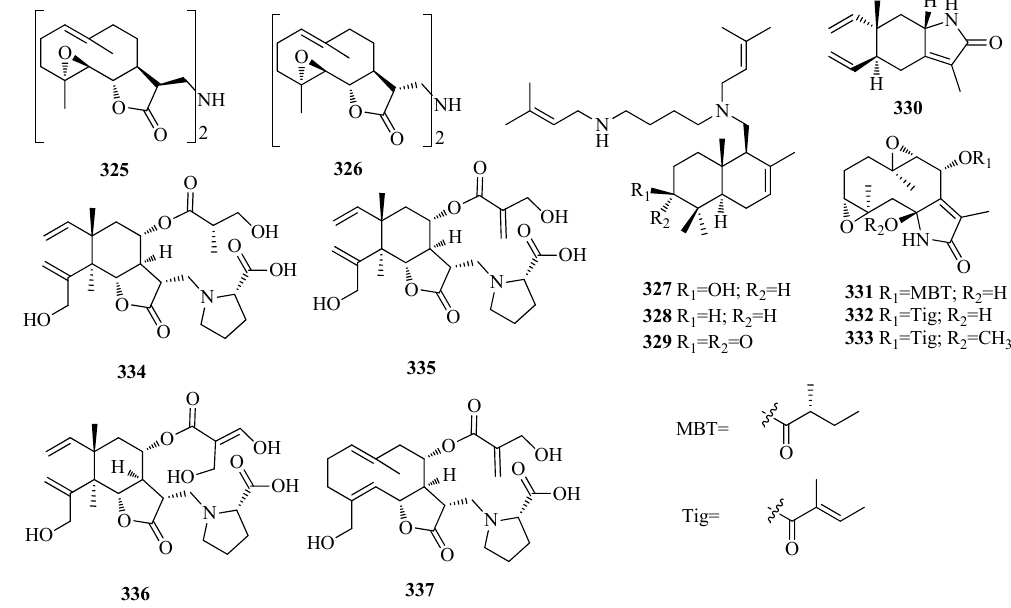
Figure 8. The structures of compounds 325 – 337.